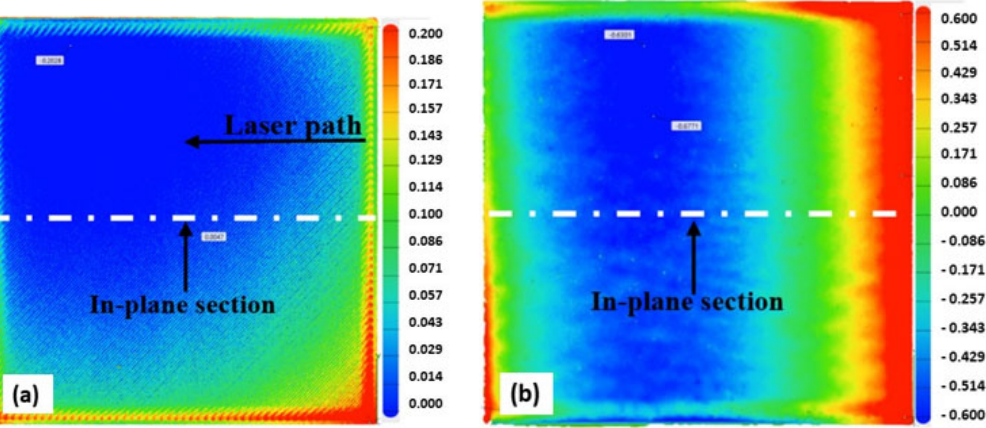
Figure 11. Three-dimensional (3D) topography of the specimen before and after the laser polishing: ( a ) unpolished; ( b ) S5: 60 W laser power, 90 kHz frequency.